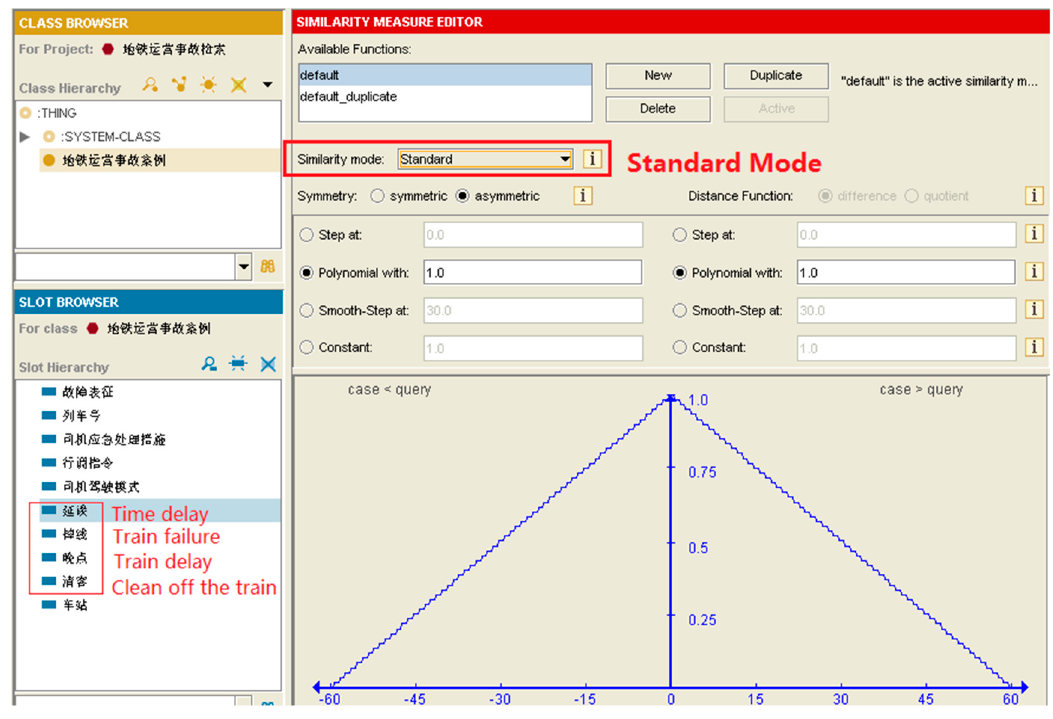
Figure 8. Similarity measures for numerical attributes in standard mode.